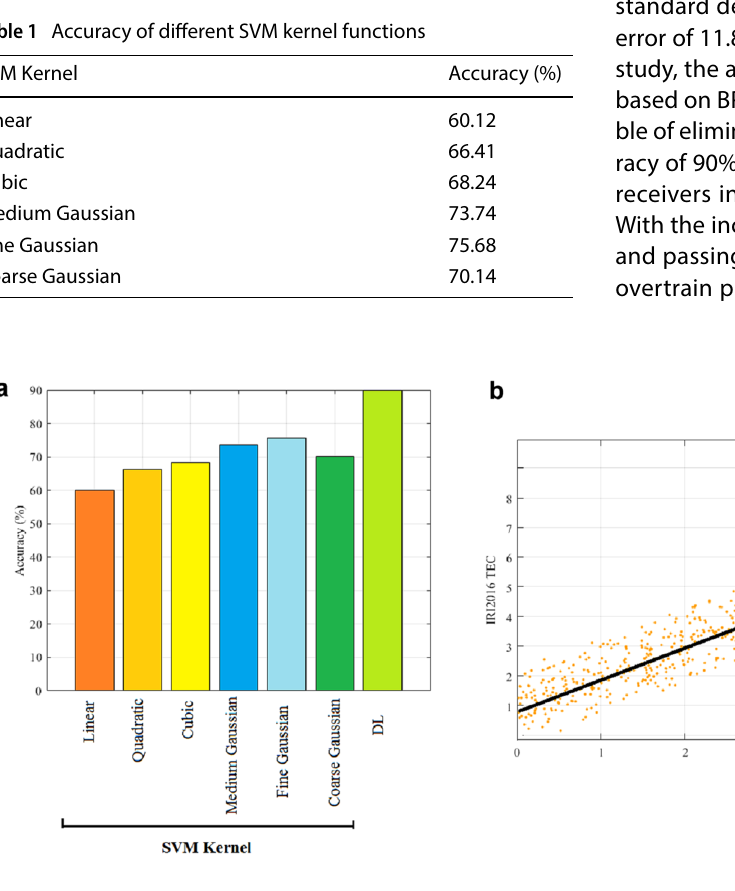
Fig. 5 a Accuracy of different methods b scatter plot of TEC from IRI2016 and GNSS during the study